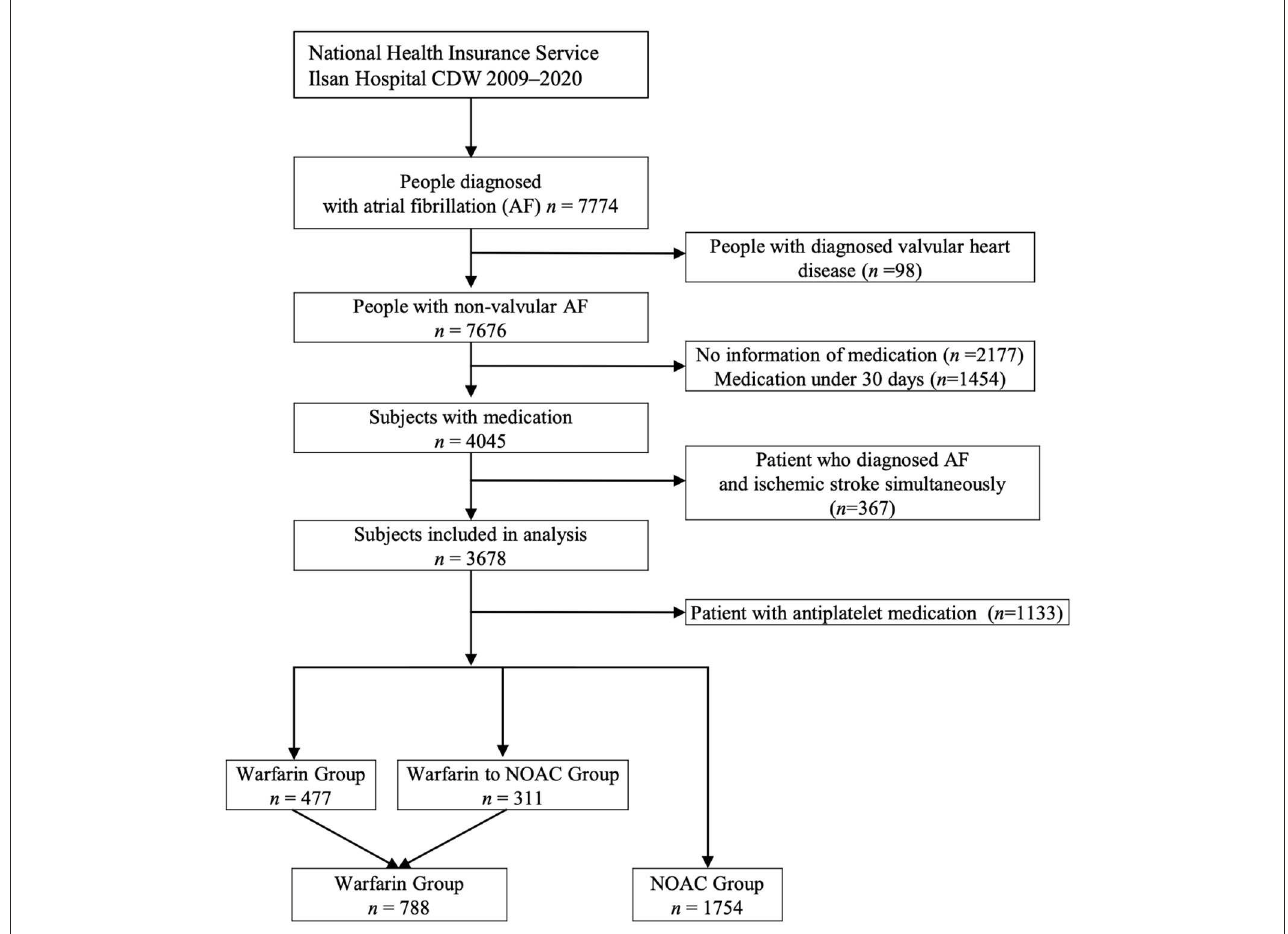
FIGURE2 The process of extracting patients with atrial fibrillation from the clinical data warehouse (CDW) and selecting subjects for the analysis (CDW-O data).